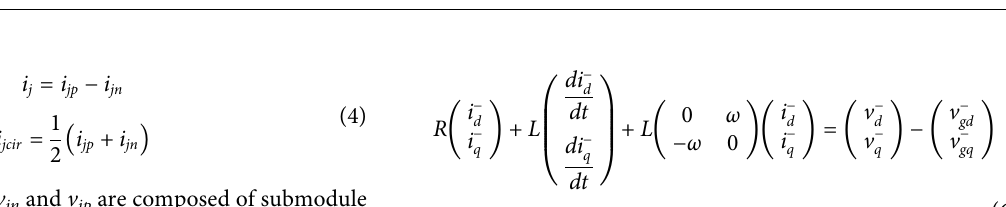
FIGURE 2 | Equivalent circuit of